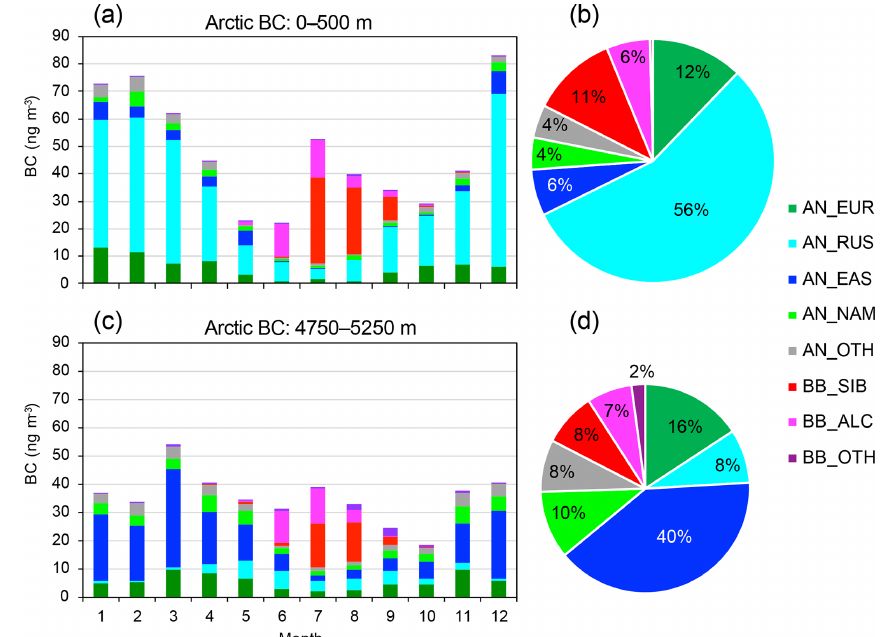
Figure 4. Contributions of anthropogenic sources (prefixed “AN_” in the legend) and open biomass burning (“BB_”) from each region to (a) seasonal variations in Arctic surface BC, (b) annual mean Arctic surface BC, (c) seasonal variations in Arctic BC at high altitudes, and (d) annual mean of Arctic BC at high